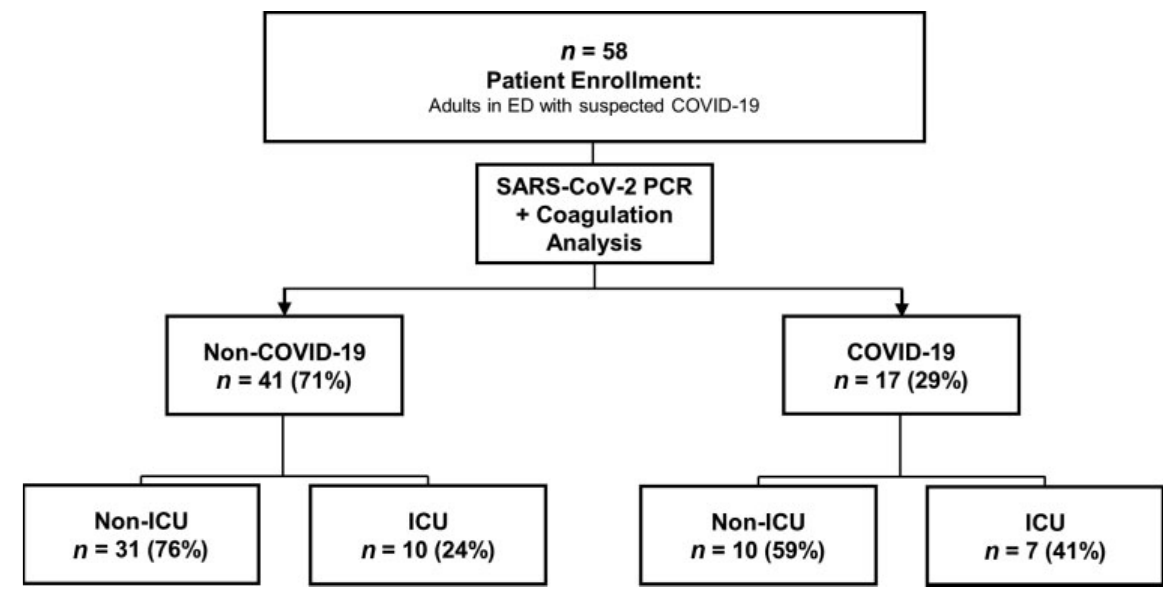
Fig. 1 Flowchart of patient enrollment and division into four groups by COVID-19 status and ICU treatment for comparison. COVID-19, coronavirus disease 2019; ICU, intensive care